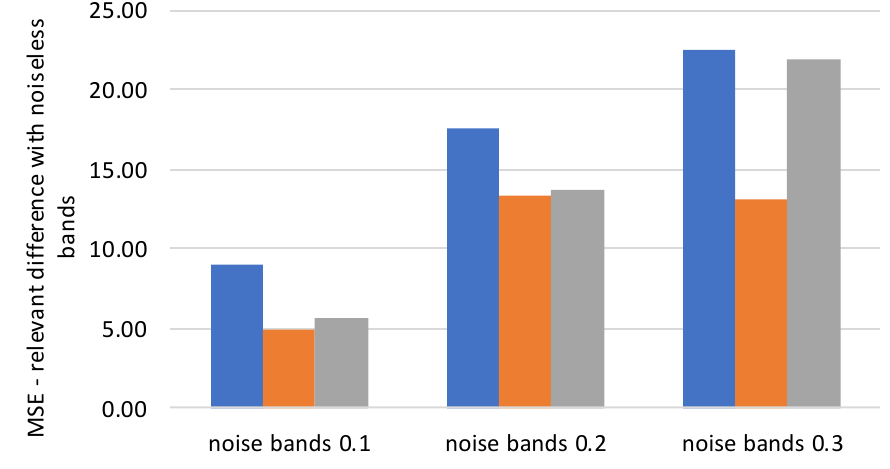
Figure 4. ( a ) Pearson regression value ( r ) of the fusion between the ground-penetrating radar (GPR) depth slices and the four bands based on the Bayesian Neural Network. ( b ) Relative difference (%) of the Mean Square Error (MSE) of the noisy data of 0.1–0.3 standard deviation against the noiseless datasets. GPR depth slice of 0.00–0.20 m is shown with blue color, depth slice of 0.20–0.40 m with an orange color and depth slice 0.40–0.60 m depth slice with a gray color.